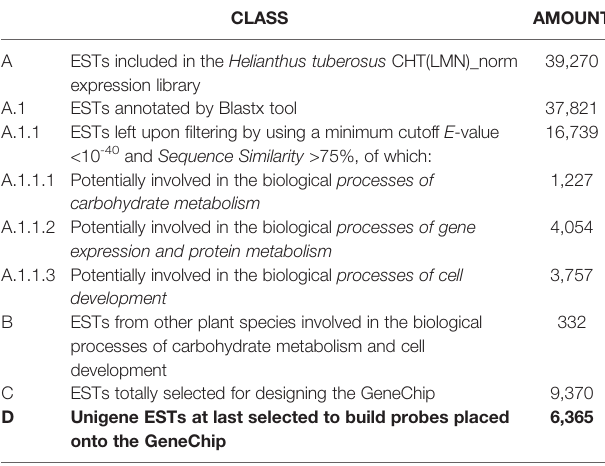
TABLE 1 | Criteria pursued to select the expressed sequence tags (ESTs) spotted on the